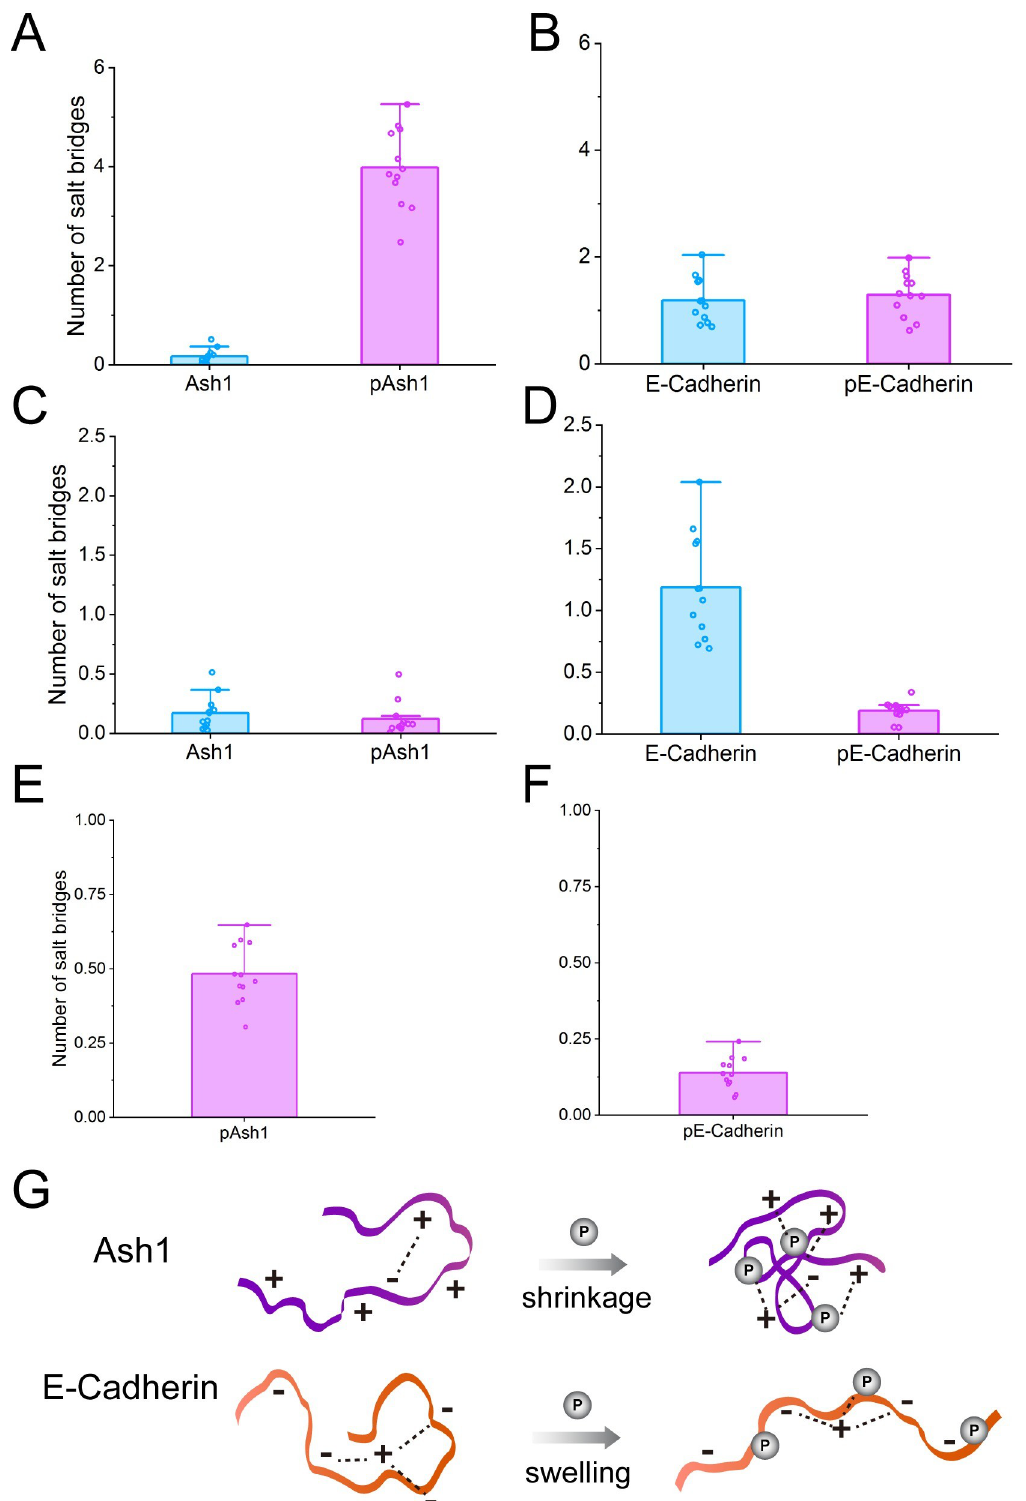
Fig 6. Analysis of salt bridges. The influence of phosphorylation on the average number of salt bridges in Ash1 and E-Cadherin (A and B) during MD simulations in 350 mM NaCl. The influence of phosphorylation on the only E/D–R/K salt bridges